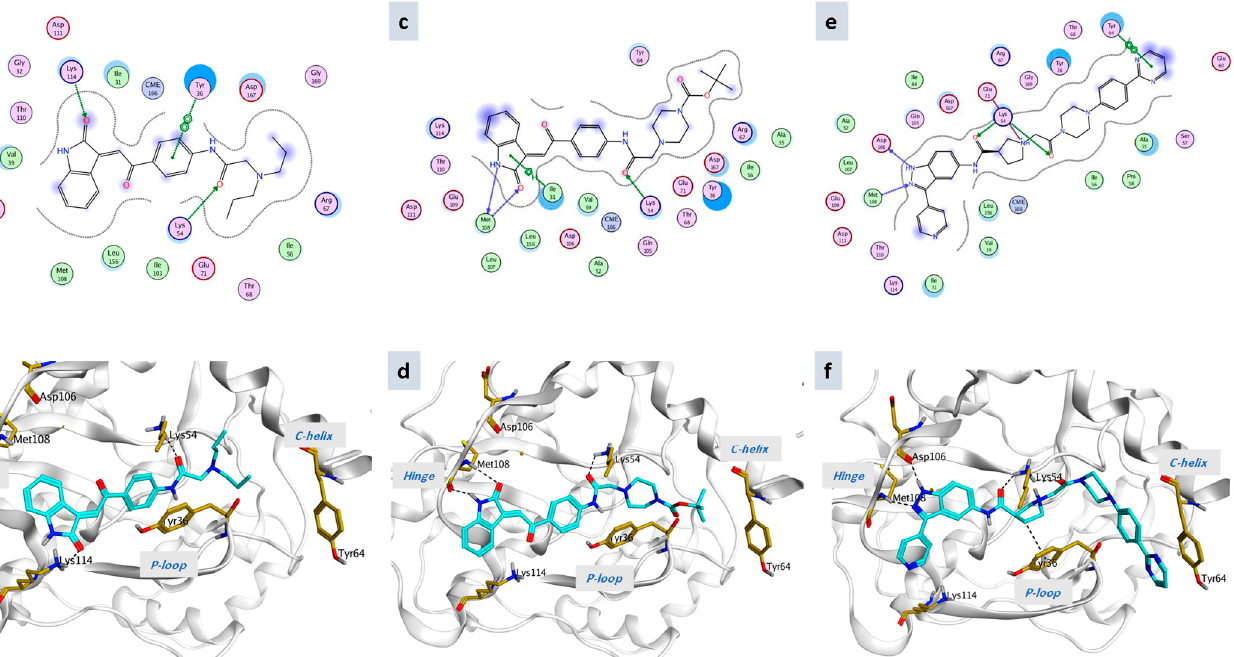
of 5b in the active site of ERK2 (PDB ID: 6GDM); ( c ) 2D representation of the ligand interactions and ( d ) 3D representation of the docking of 5g in the active site of ERK2 (PDB ID: 6GDM); ( e ) 2D representation of the ligand interactions and ( f ) 3D representation of the docking of SCH772984 in the active site of ERK2 (PDB ID: 6GDM).